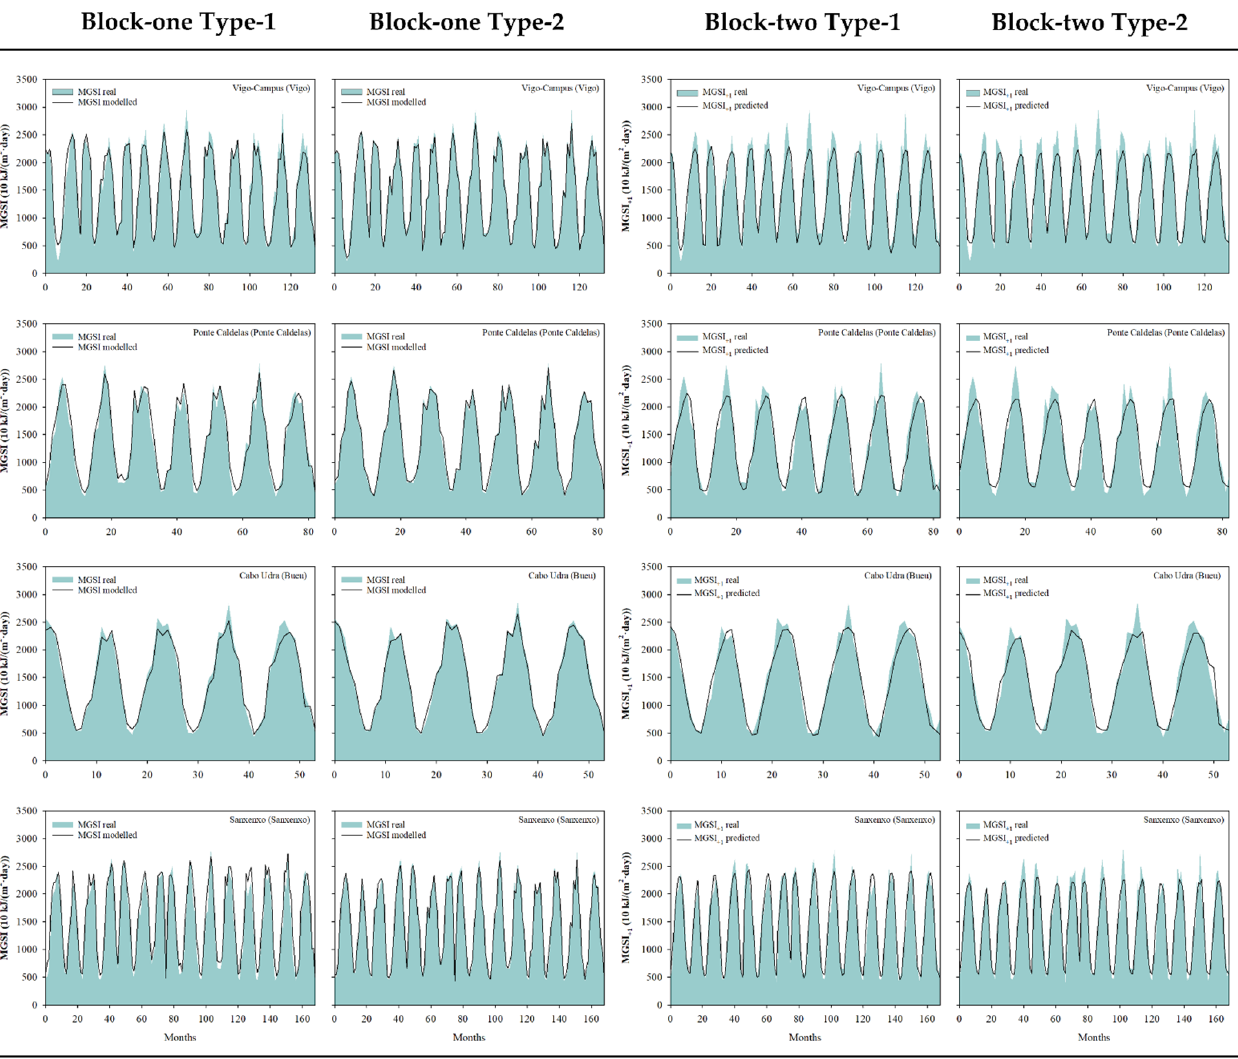
Figure 4. Real and modelled/predicted MGSI values for each measurement station according to the combination of the used variables to model the MGSI (Block-one Type-1 and Block-one Type-2) and to predict MGSI one month ahead (Block-two Type-1 and Block-two Type-2) for the stations: Q 2 —Vigo-Campus (Vigo), Q 3 —Ponte Caldelas (Ponte Caldelas), Q 4 —Cabo Udra (Bueu) and Q 5 —Sanxenxo (Sanxenxo). The cyan shade is the real value of MGSI and the black line is the modelled/predicted MGSI value by each selected ANN model. Data from Puga-Gil (2022) [31].